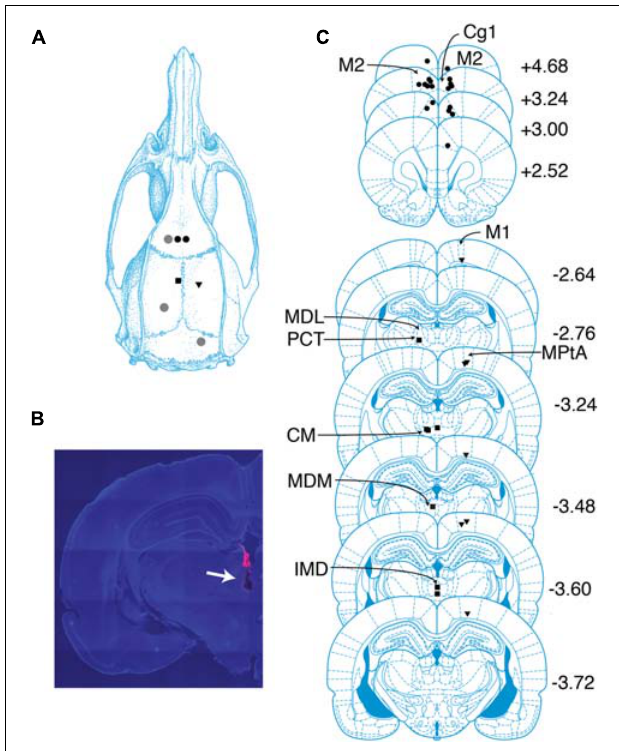
FIGURE 1 | Overview of recording sites. (A) Schematic of targeted sites. Shapes represent locations where screws (gray circles) and electrodes (black circles, PFC; squares, CT; triangles, PC) were placed. (B) Coronal section containing the tract of an electrode localized to the CT. Tract is indicated with an arrow. Pink color is a dye used to aid with tract visualization. (C) Locations of probes in PFC, PC, and CT determined by histological analysis. Shapes same as in (A) . The center of each shape marks the tip of one electrode. Numbers indicate anterior–posterior position (mm) relative to bregma. cg1, cingulate cortex area 1; CM, central medial thalamic nucleus; IMD, intermediodorsal thalamic nucleus; M1, primary motor cortex; M2,